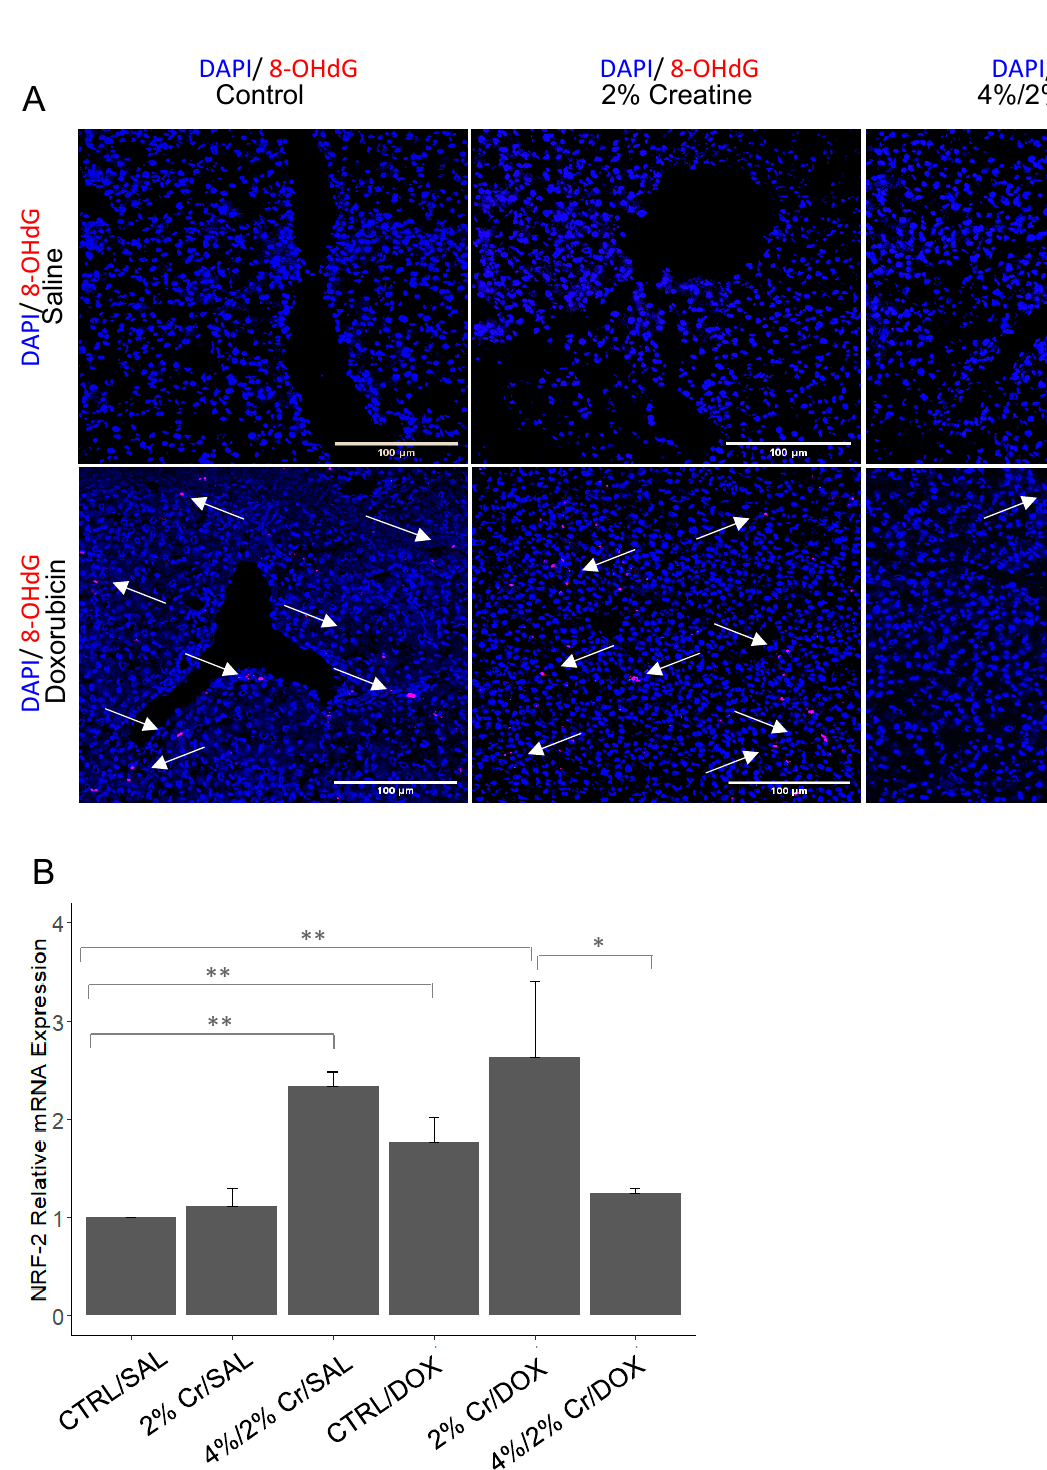
Figure 4. Immunofluorescence staining and mRNA expression of oxidative stress-related genes. Antibody against 8-OHdG is shown in red and the nucleus stained with DAPI is shown in blue. The arrow shows the positive staining of 8-OHdG. 8-OHdG was expressed in DOX treated groups (bottom row), while there was no indication of 8-OHdG expression in controls (top row). Pictures were taken under 20 × magnification ( A ). Low mRNA expression of NRF-2 was observed in CTRL/SAL and 2% Cr/SAL while elevated mRNA expression of NRF-2 was detected in 4%/2% Cr/SAL, CTRL/DOX and 2% Cr/DOX ( B ). The image was obtained under 20 × magnification. Four biological replicates are used, and mRNA expression is relative to ACTB. Data is reported as mean ± SE. * p < 0.05, ** p <